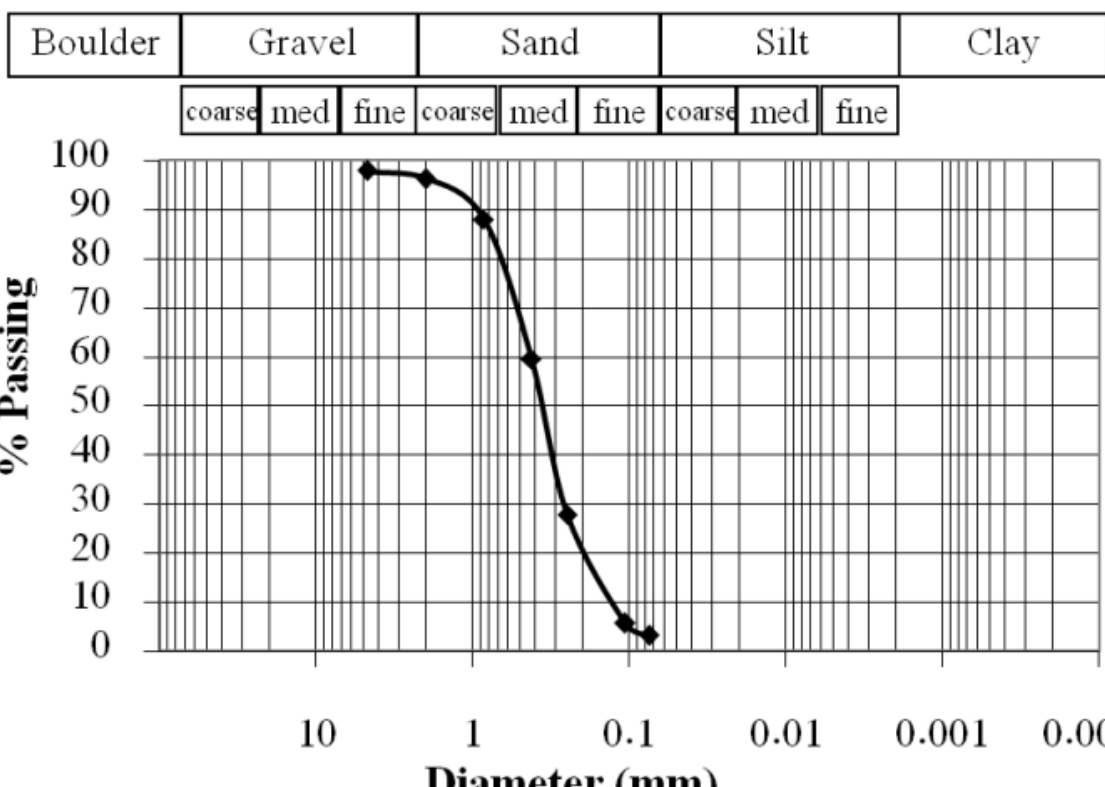
Figure 16. The sieve analysis of specimen 10 at 89 E km at Sarapum